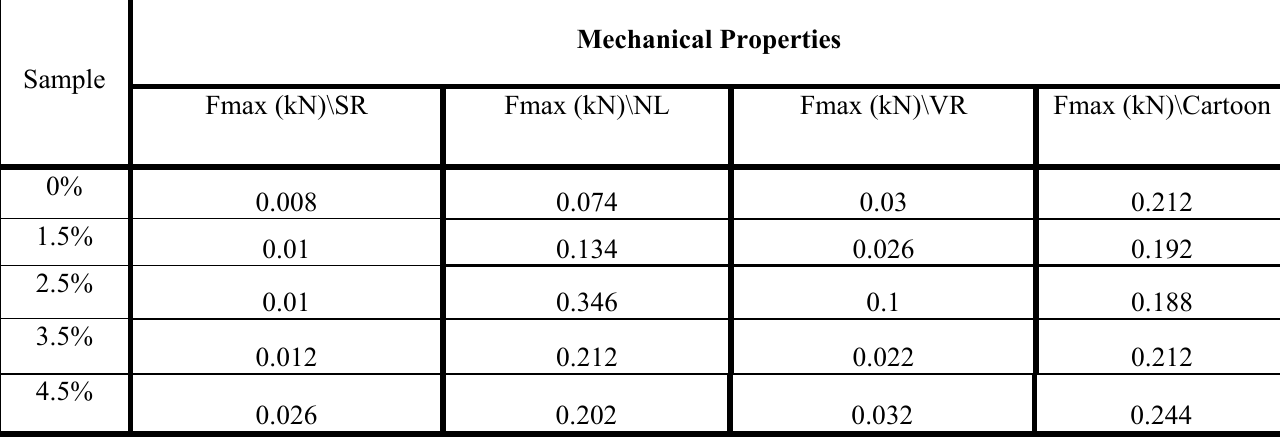
Table 3: Main mechanical properties of SR, NL, VR, cartoon sample for shear